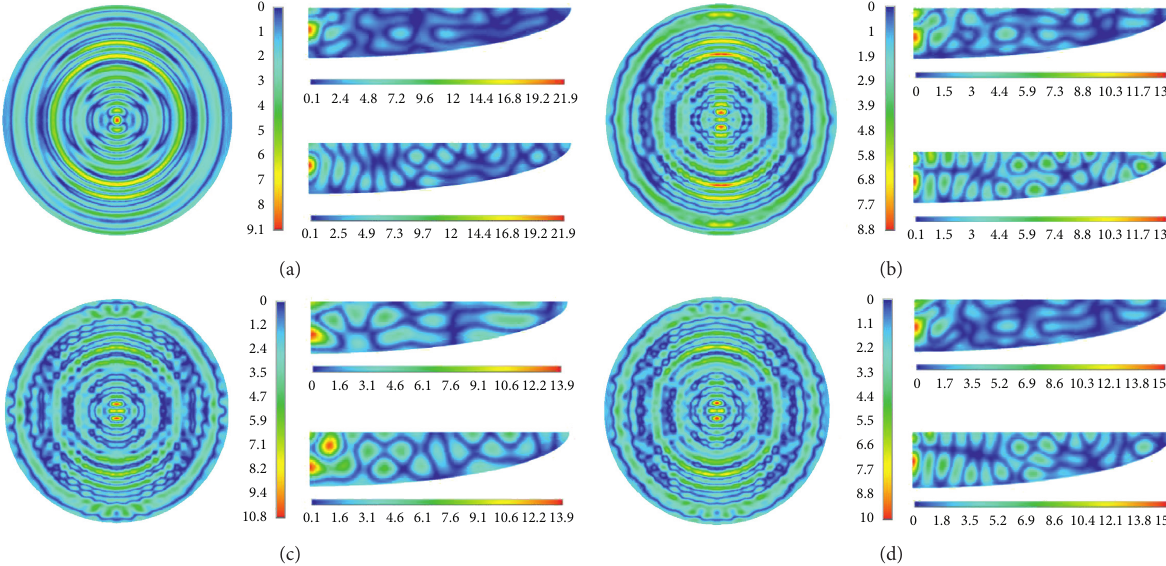
Figure 16: The displacement amplitude of the homogeneous sedimentary basin ( f � 4.0Hz): (a) no buildings; (b) D � 55m; (c) D � 62.5m; (d) D � 70 m.